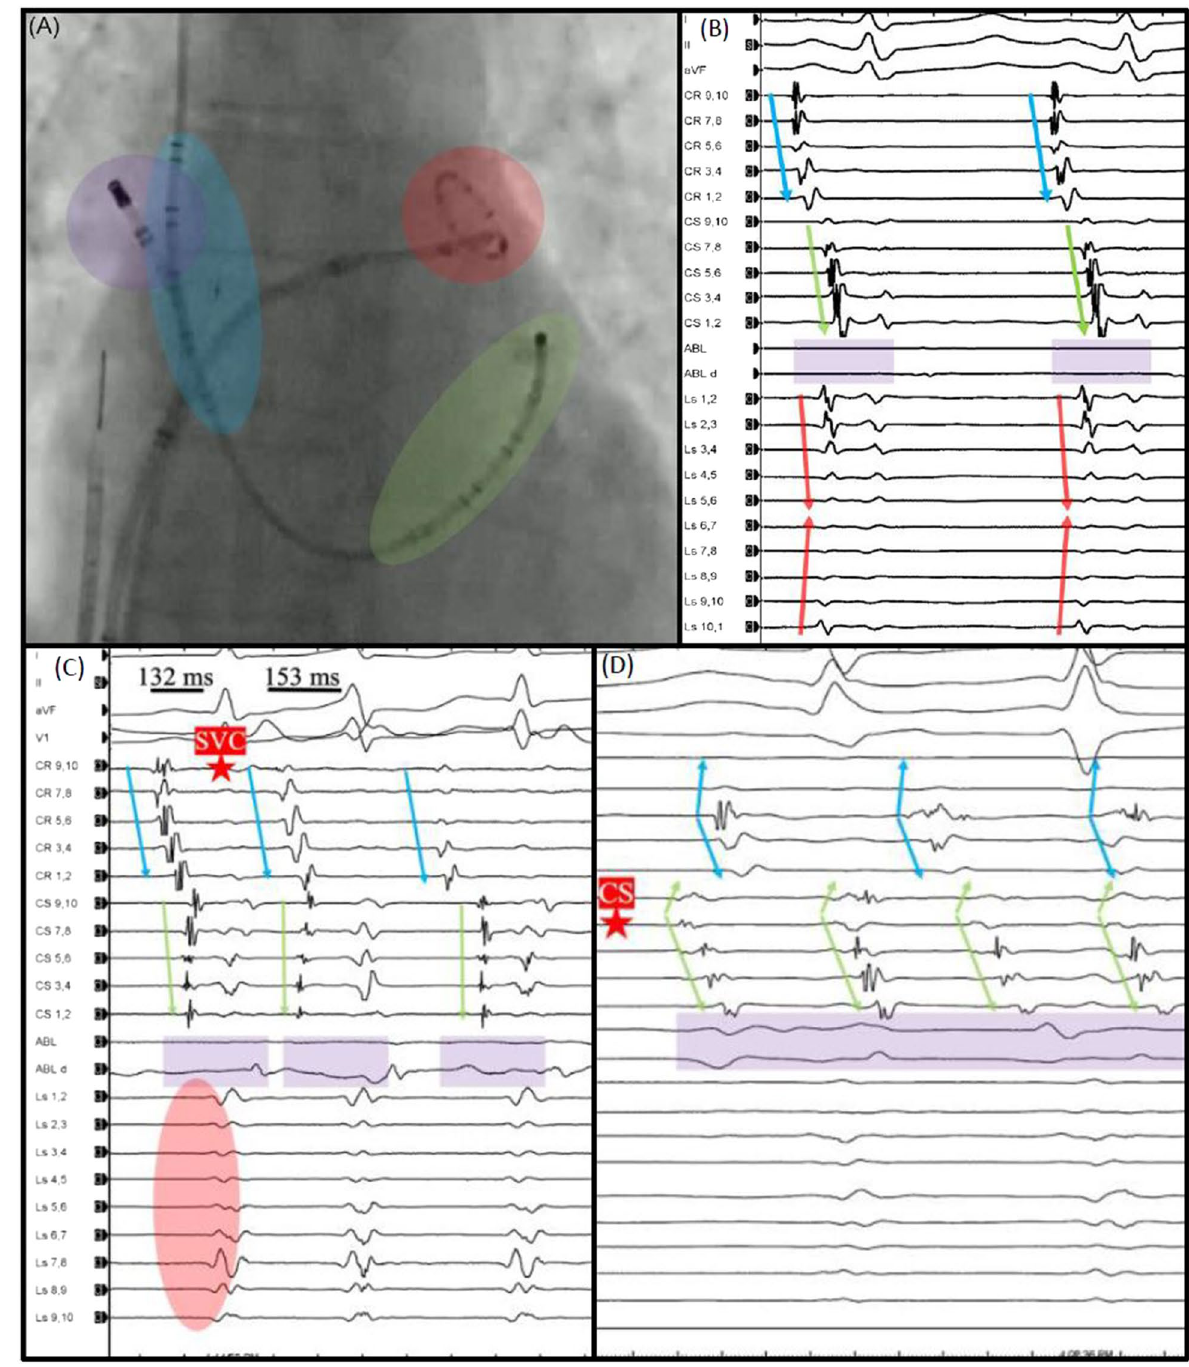
Fig. 1 Example of the catheter setup during isoproterenol provocation test and examples of activation pattern of PACs. A Duodecapolar catheter with electrodes spanning from the SVC, right atrium/CT [blue] to the CS [green], ablation catheter in the right superior PV recording the far‑field IAS [violet], 10‑pole circular mapping catheter in the left superior PV recording the far‑field LAA activity [red]. B Activation pattern during sinus rhythm. C Example of activation pattern PACs from the CS. The earliest activation (red star) is recorded in the dipole CS 7–8 of the distal segment of the duodecapolar catheter (inside the CS). D Example of activation pattern of PACs from the LAA. The earliest activation (red star) is recorded by the circular mapping catheter inside the left superior PV recording the far‑field from the LAA. (Della Rocca, Di Biase et al.